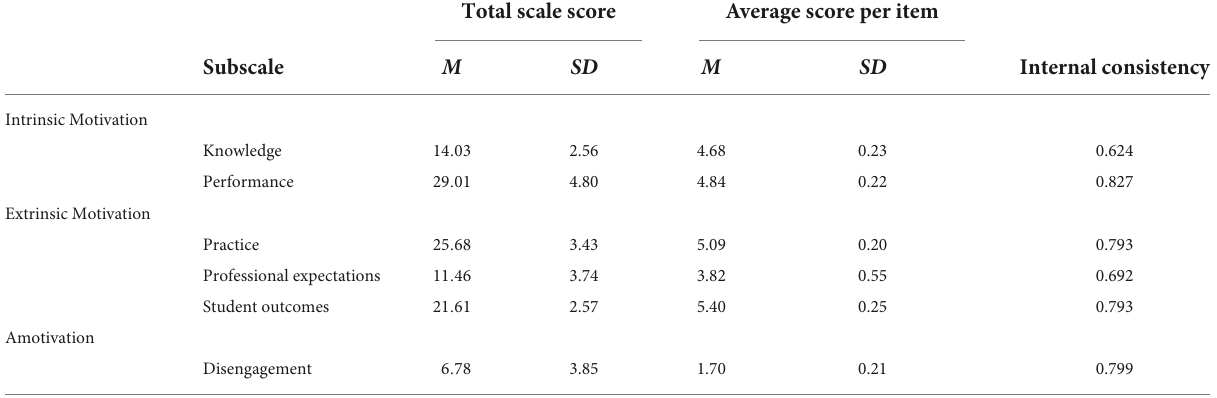
TABLE 3 Descriptive statistics and internal consistency coefficients for the motivation subscales.